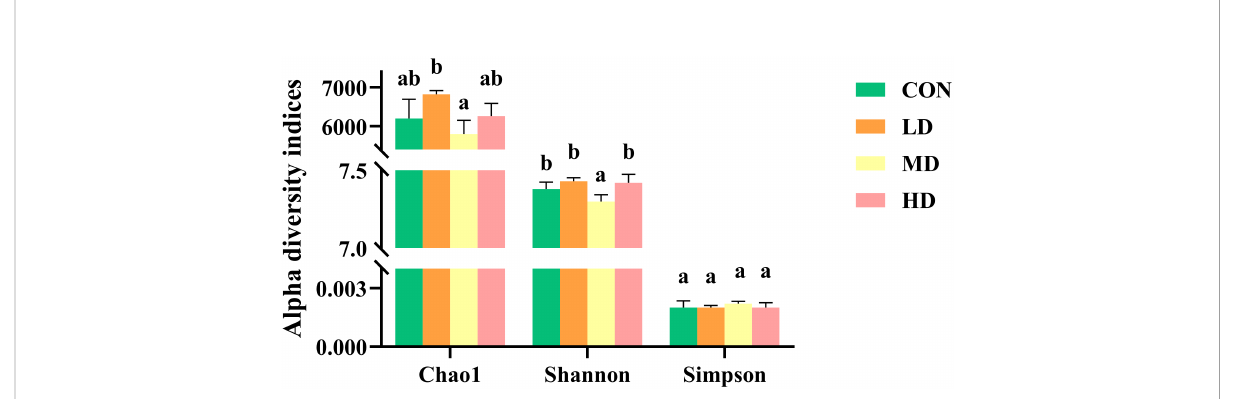
FIGURE 6 Bacterial community alpha diversity indices, including Chao1, Shannon, and Simpson in sediment of the CON, LD, MD, and HD groups. Different lowercase letters in the same column represent signi fi cant differences between the CON, LD, MD, and HD groups ( P <